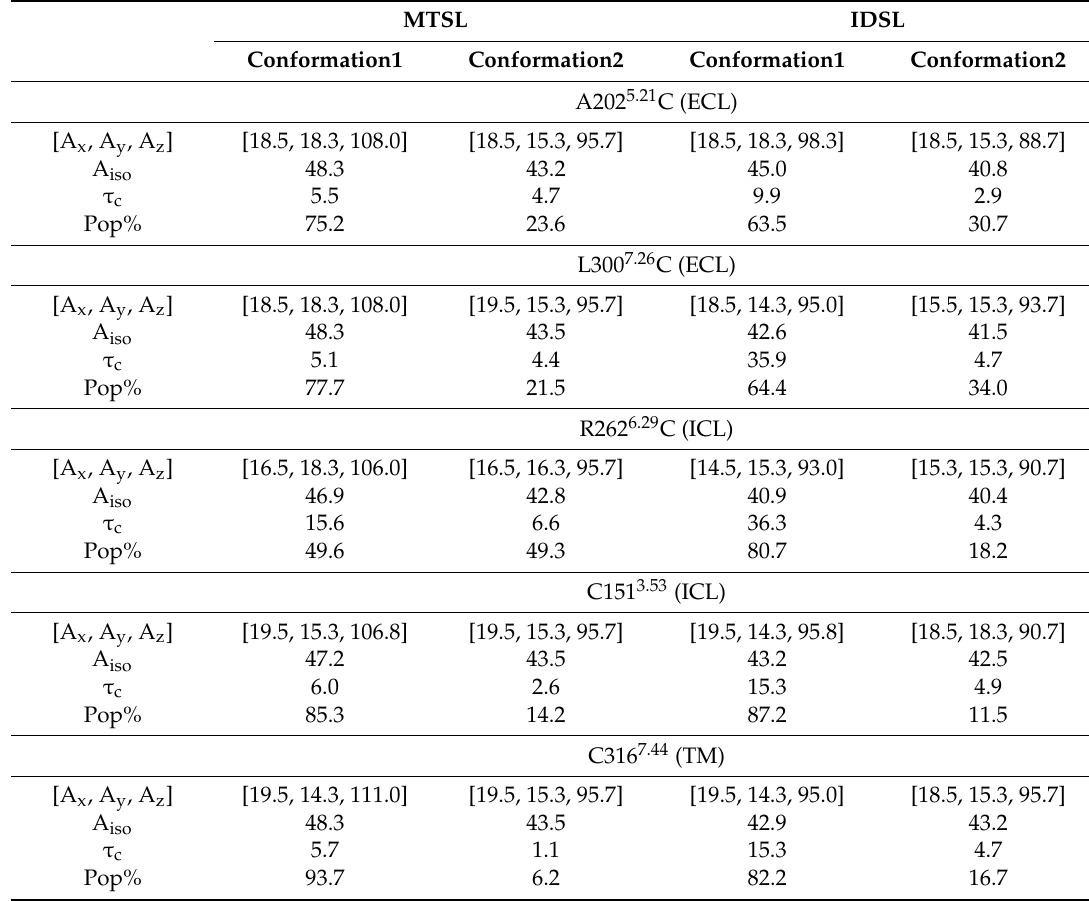
Table 2. EPR spectral simulation data of single spin labeled Y 2 R by MTSL and IDSL at extracellular (ECL), intracellular (ICL) and transmembrane (TM) positions. The hyperfine tensor and isotropic hyperfine couplings and the rotational correlation times are given in MHz and nanoseconds,